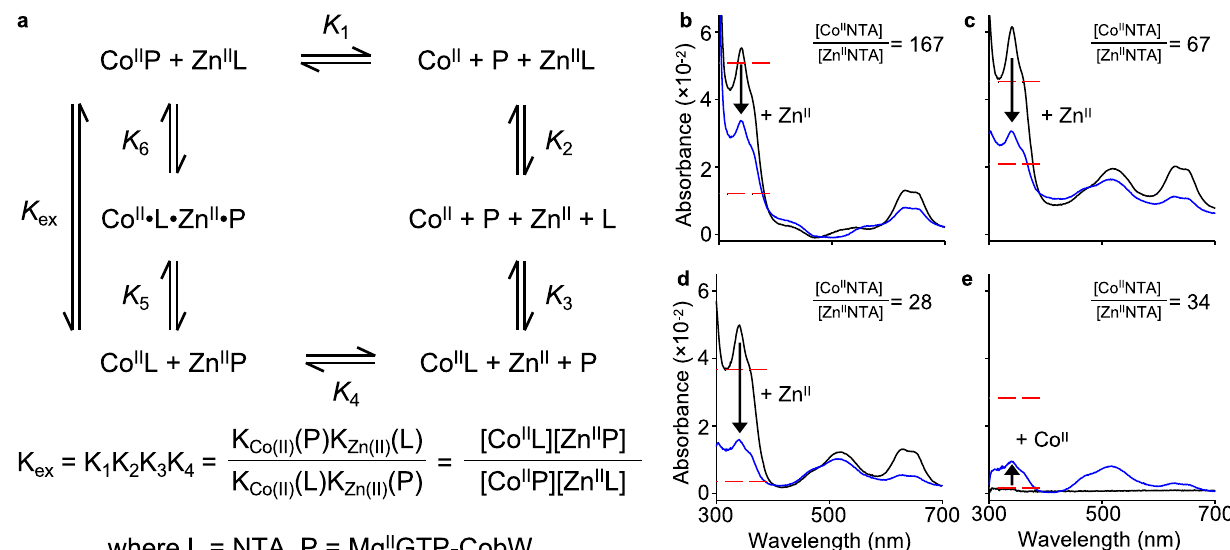
Fig. 4 Mg II GTP-CobW binds Zn II with sub-picomolar af fi nity. a Representation of the equilibrium for exchange of Co II and Zn II between ligand (L = NTA) and protein (P = Mg II GTP-CobW). b – e Absorbance (relative to metal-free solution) of solutions of CobW (17.9 – 20.4 µ M), Mg II (2.7 mM), GTP (200 µ M) and NTA (0.4 – 4.0 mM) upon ( b – d ) fi rst addition of Co II (black trace) then Zn II (blue trace) or ( e ) the reverse, at equilibrium ( n = 1 for each panel). The absorbance peak at 339 nm corresponds to Co II -bound protein. An excess of ligand NTA was used to buffer both metals in each experiment: varying the ratios of ligand-bound metal ions ([Co II NTA]/[Zn II NTA] = 28 – 167) shifted the ratios of Co II - and Zn II -bound protein as predicted by the equilibrium exchange constant in a . Consistent K Zn(II) values for Mg II GTP-CobW were generated at all tested conditions (Supplementary Table 4). Dashed red lines